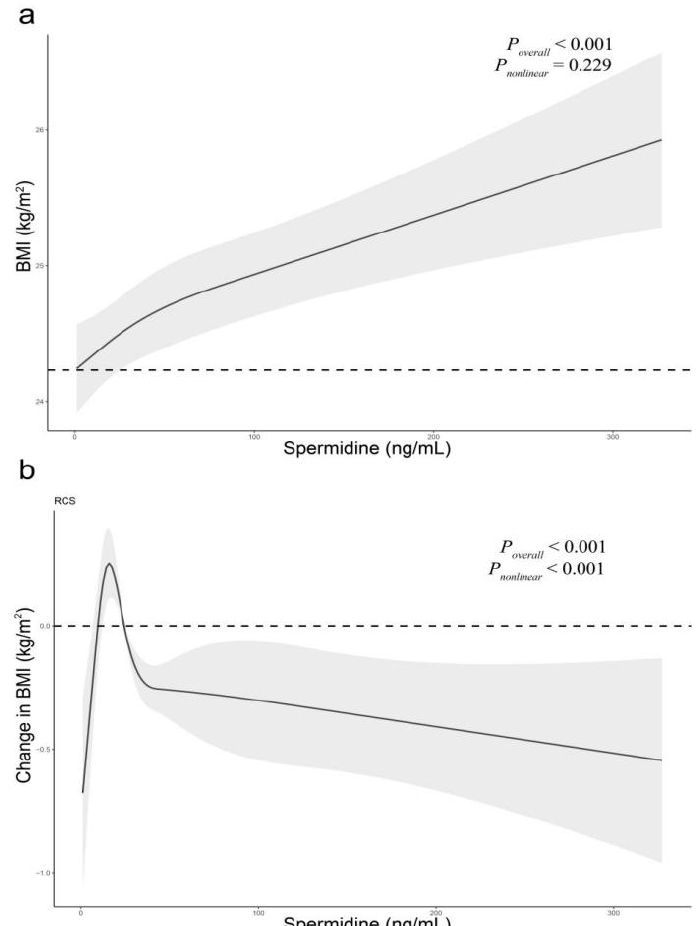
Figure 3. The relations of serum spermidine with the baseline BMI and change in BMI. In the cross-sectional study, we adjusted for gender, age, smoking, drinking, ethnicity, physical labor levels, fruit/vegetables intake levels, whole grain intake levels, triglyceride, HDL-C, LDL-C, total cholesterol, history of diabetes, and history of stroke. In the follow-up study, we additionally adjusted for baseline BMI compared to the cross-sectional study. ( a ), baseline BMI; ( b ), change in BMI. Table 3. OR and 95%CIs of baseline serum spermidine levels for the increase in body mass index in the follow-up study.